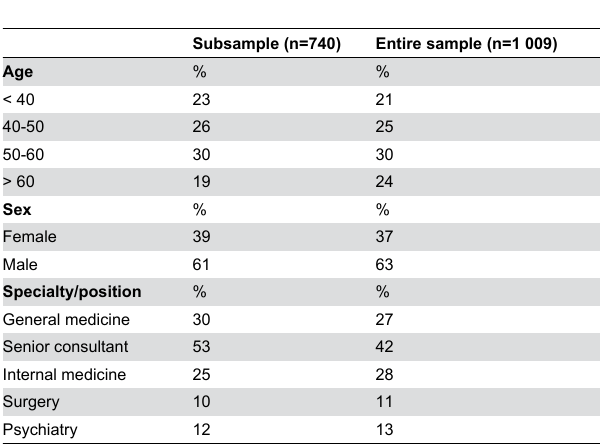
Table 1. Demographic description of the